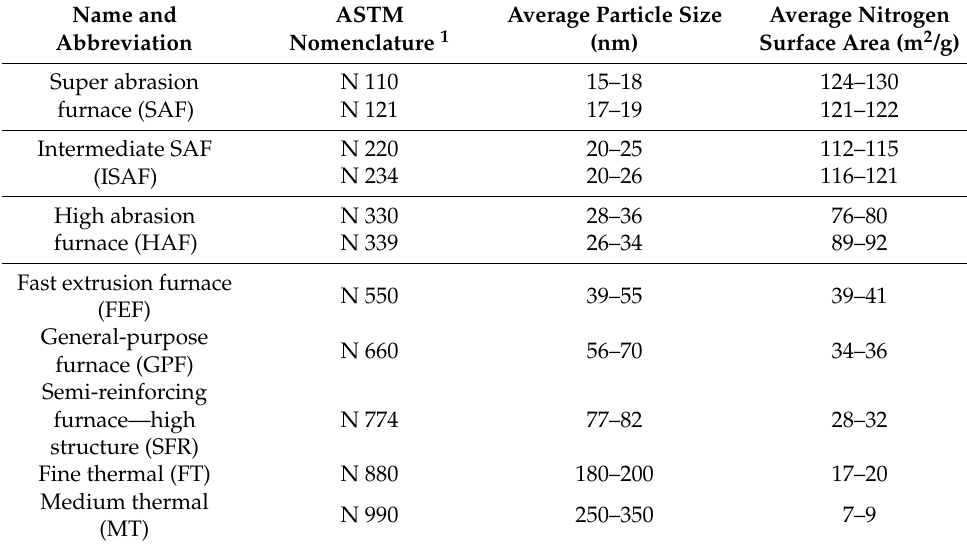
Table 1. Typical rubber grade carbon black (CB) with average particle sizes and nitrogen surface